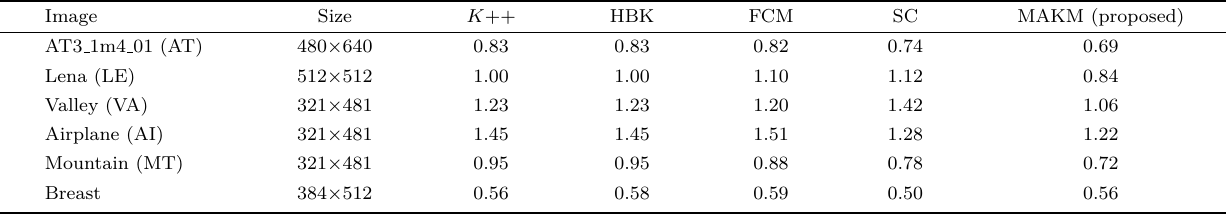
Table 6 Comparison of proposed algorithm with K ++, HBK, FCM, and SC in terms of mean RMSE for AT, LE, VA, AI, MT, and Breast images Image